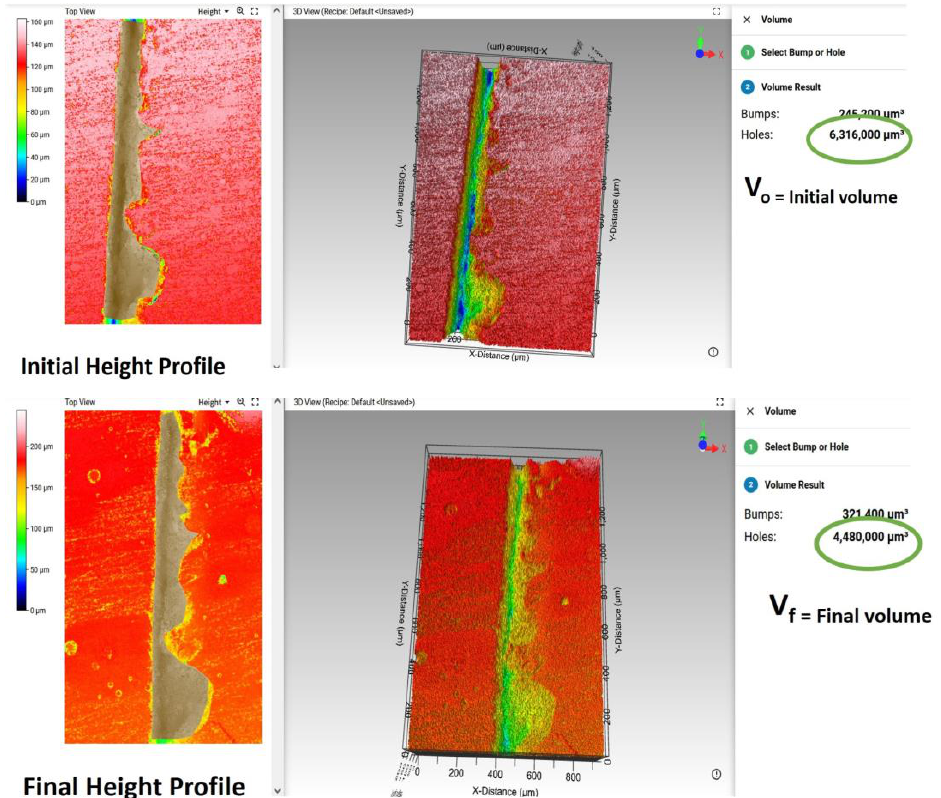
Figure 1. Example of V o and V f calculations using Mountain Map Premium 7.1 software. They show how the crack is delimited before and after the self-healing process, and the values provided by the software in both cases.